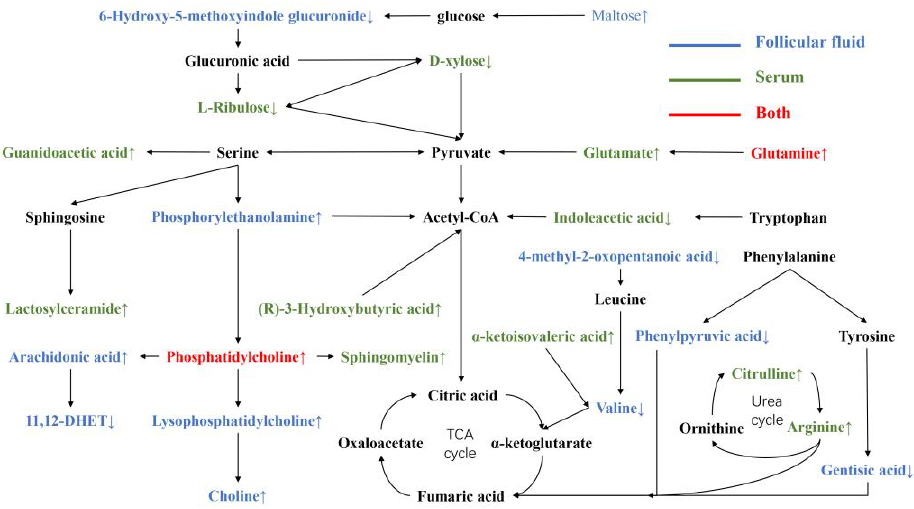
Figure 3. Differential metabolite network metabolism map in dairy cows with inactive ovaries. ↑ and ↓ represent increase and decrease, respectively. Blue means follicular fluid samples, green means serum samples, and red means both. Black means no difference between serum and follicular fluid.